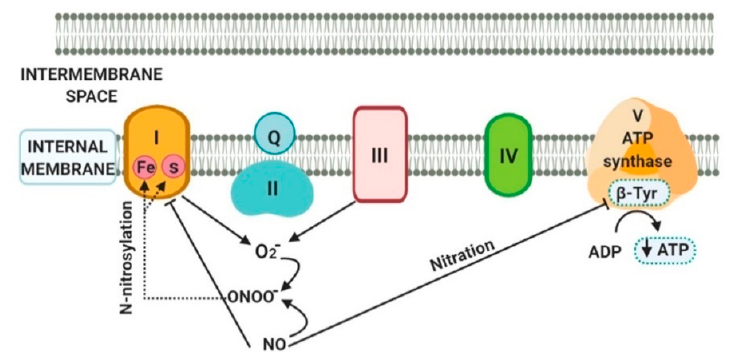
Figure 2. Interaction between nitrosative stress (NSS) and the mitochondrial proteins. The nitration of Tyr residues in the catalytic β subunit of the complex V decrease adenosine triphosphate (ATP) levels. The ONOO − impairs complex I by S-nitrosylation affecting the iron-sulphur centers.